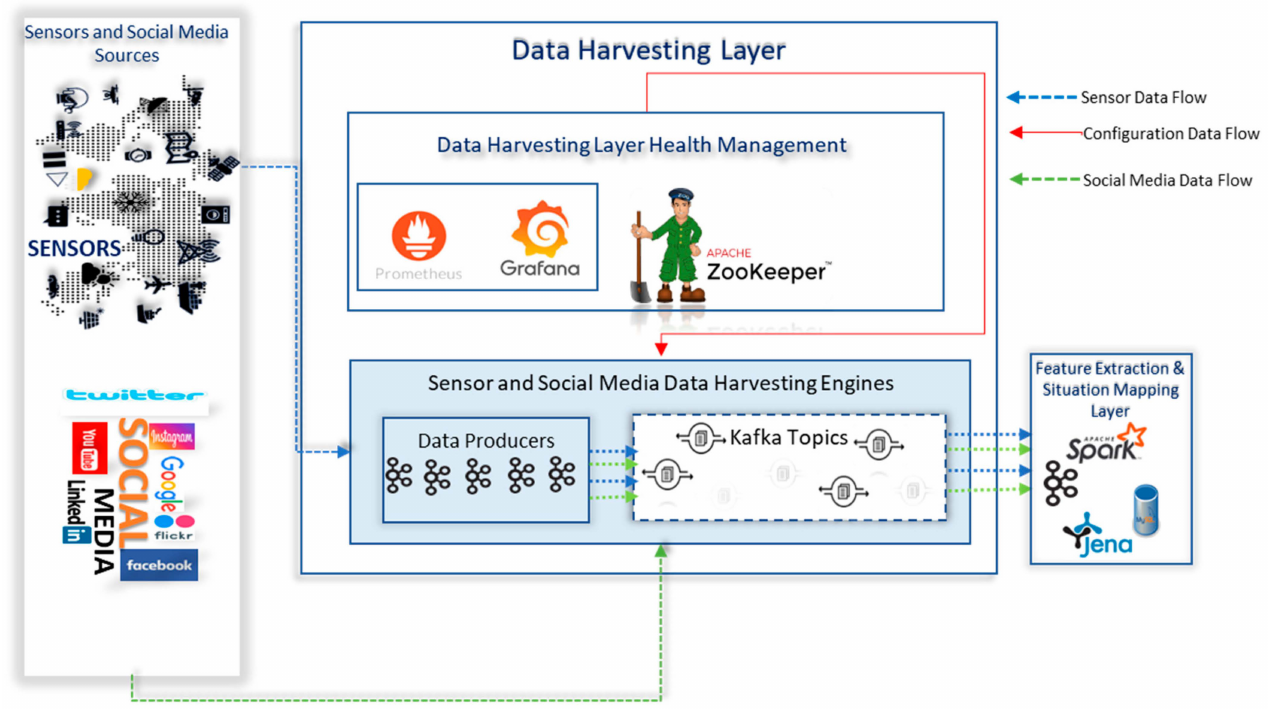
Figure 3. Implementation model of data-harvesting layer of CPSA